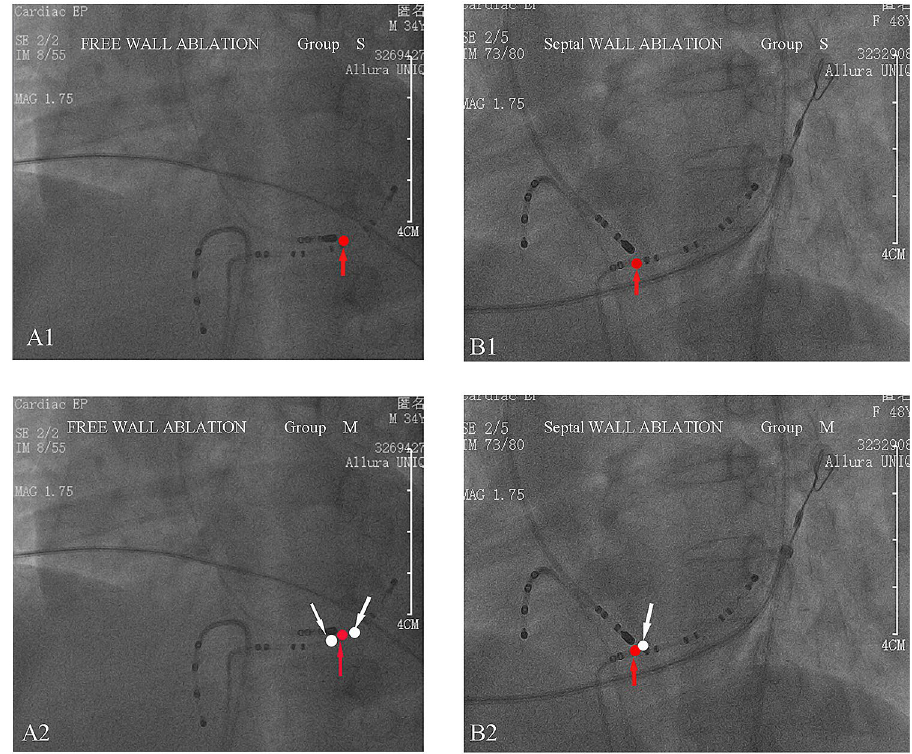
Figure 1. ( A1 ) Shows the localization of the ablation site for a free wall Ap in group S (the red arrow refers to the initial site of successful ablation). ( A2 ) Shows additional ablation sites on both sides adjacent to the initial site of successful ablation for the free wall Ap (the white point refers to the additional ablation site). Septal wall Aps in group M were treated with an additional ablation on the side adjacent to the first successful site and away from the septum ( B1 , B2 ).